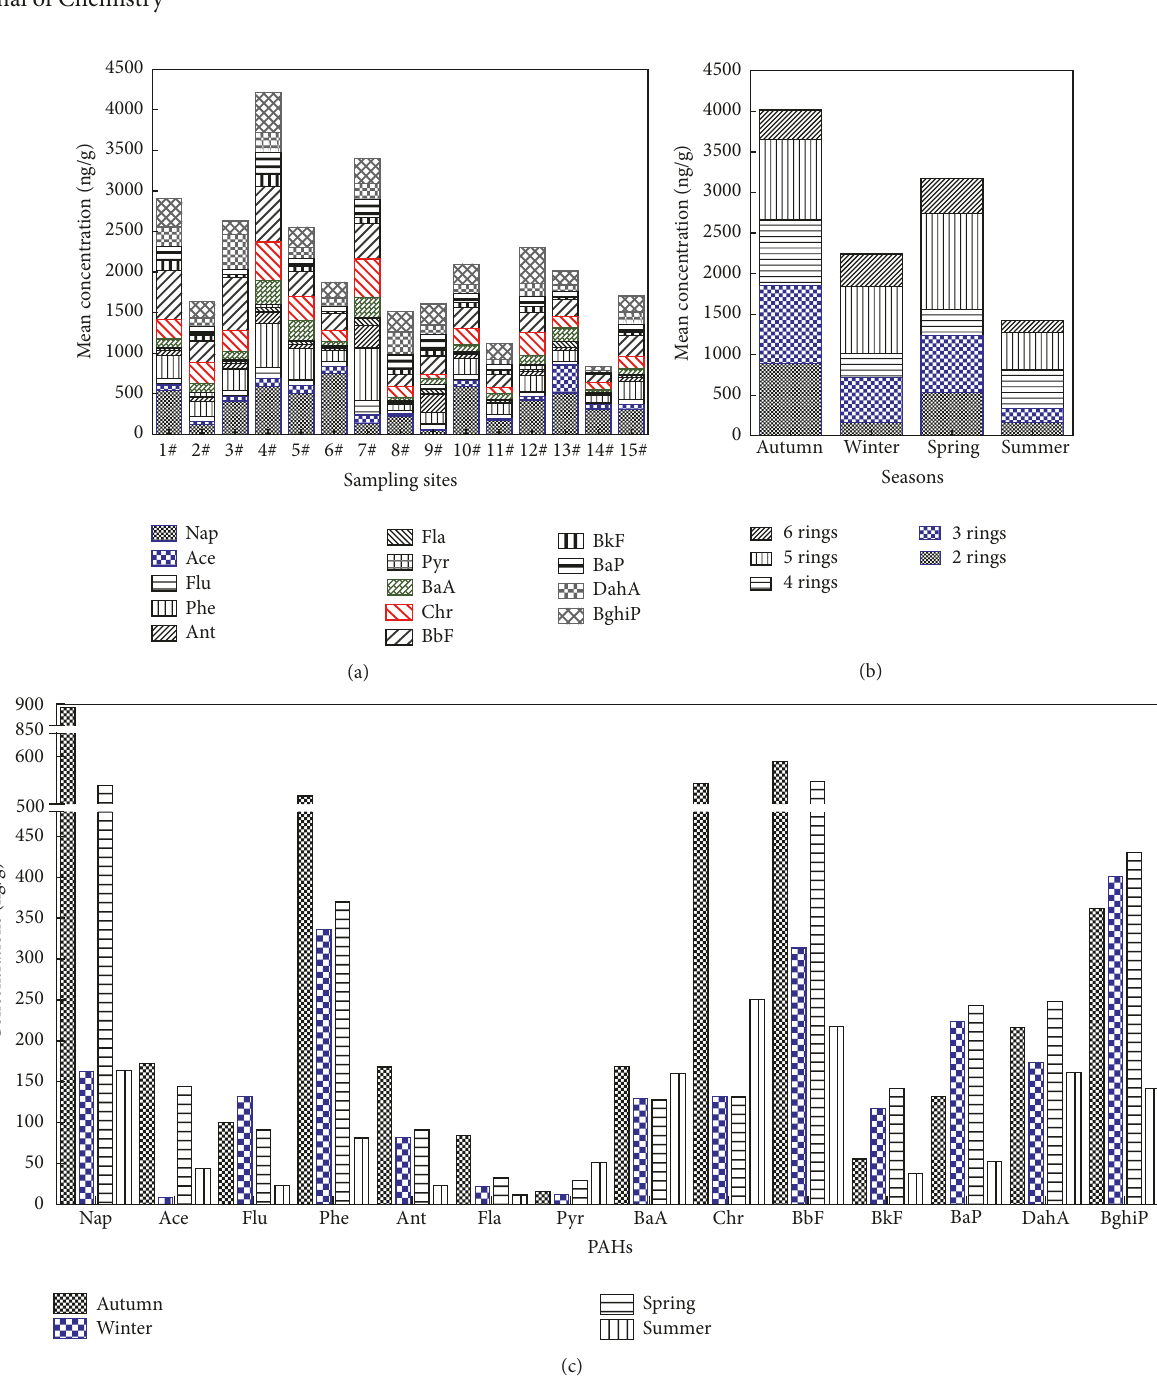
Figure 2: Temporal (b and c) and spatial variation (a) of ∑ PAHs in